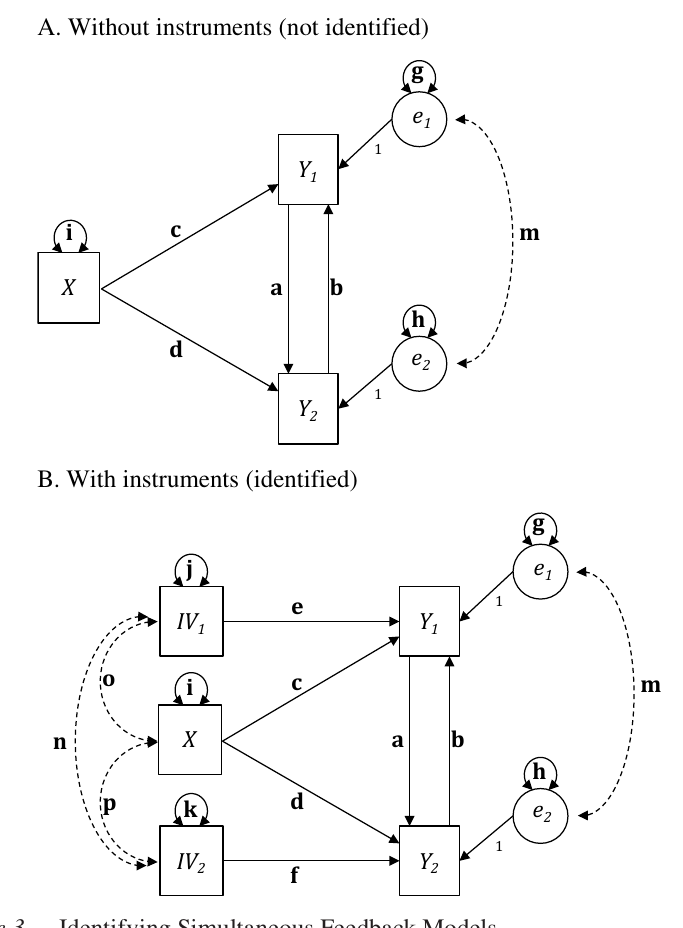
Figure 3. Identifying Simultaneous Feedback Models